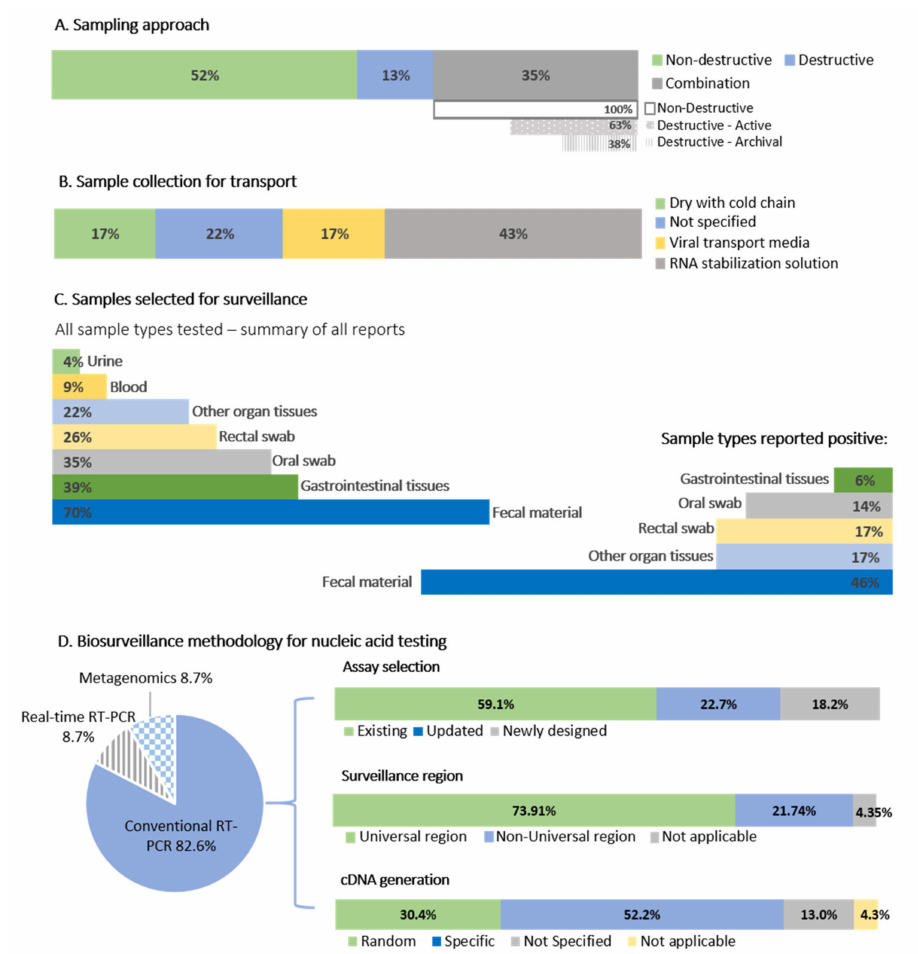
Figure 3. A summary of coronavirus sampling approaches and methodology. ( A ) The sampling approaches of the 23 primary surveillance reports. Combination studies are split into those employing new or archival destructive sampling. ( B ) Sample preservation methods. ( C ) Sample types selected for surveillance and samples testing positive. ( D ) Biosurveillance methodology for nucleic acid testing, percentage of studies using conventional, real-time, or metagenomic approaches. The conventional assays were further split into existing assays from the literature, updated exiting assays, or whether new assays were developed. The percentages of studies targeting the ‘universal surveillance region’ (see text for an explanation) contrast to those using different genome regions, and whether specific or random primers were chosen for cDNA